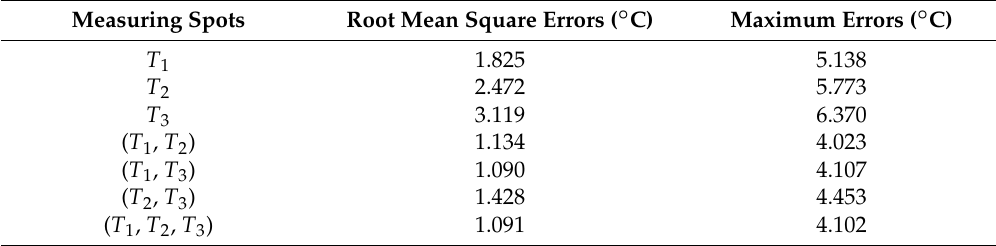
Table 1. Estimated temperature errors based on support vector regression (SVR) with different measuring spots combination.